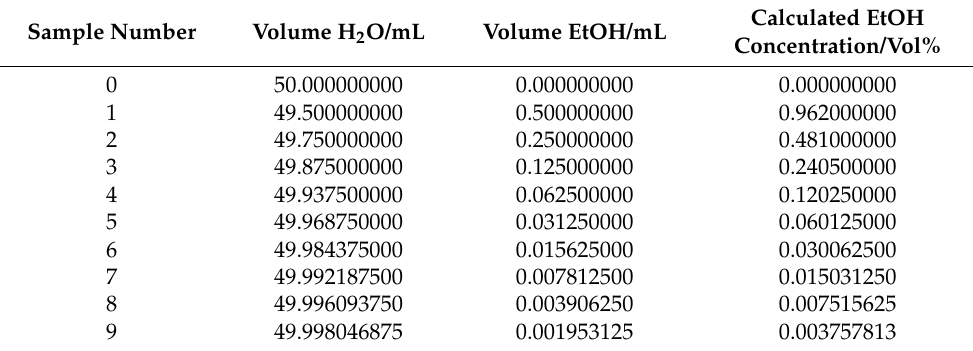
Table 1. Dedicated samples numbers with calculated ethanol concentration.